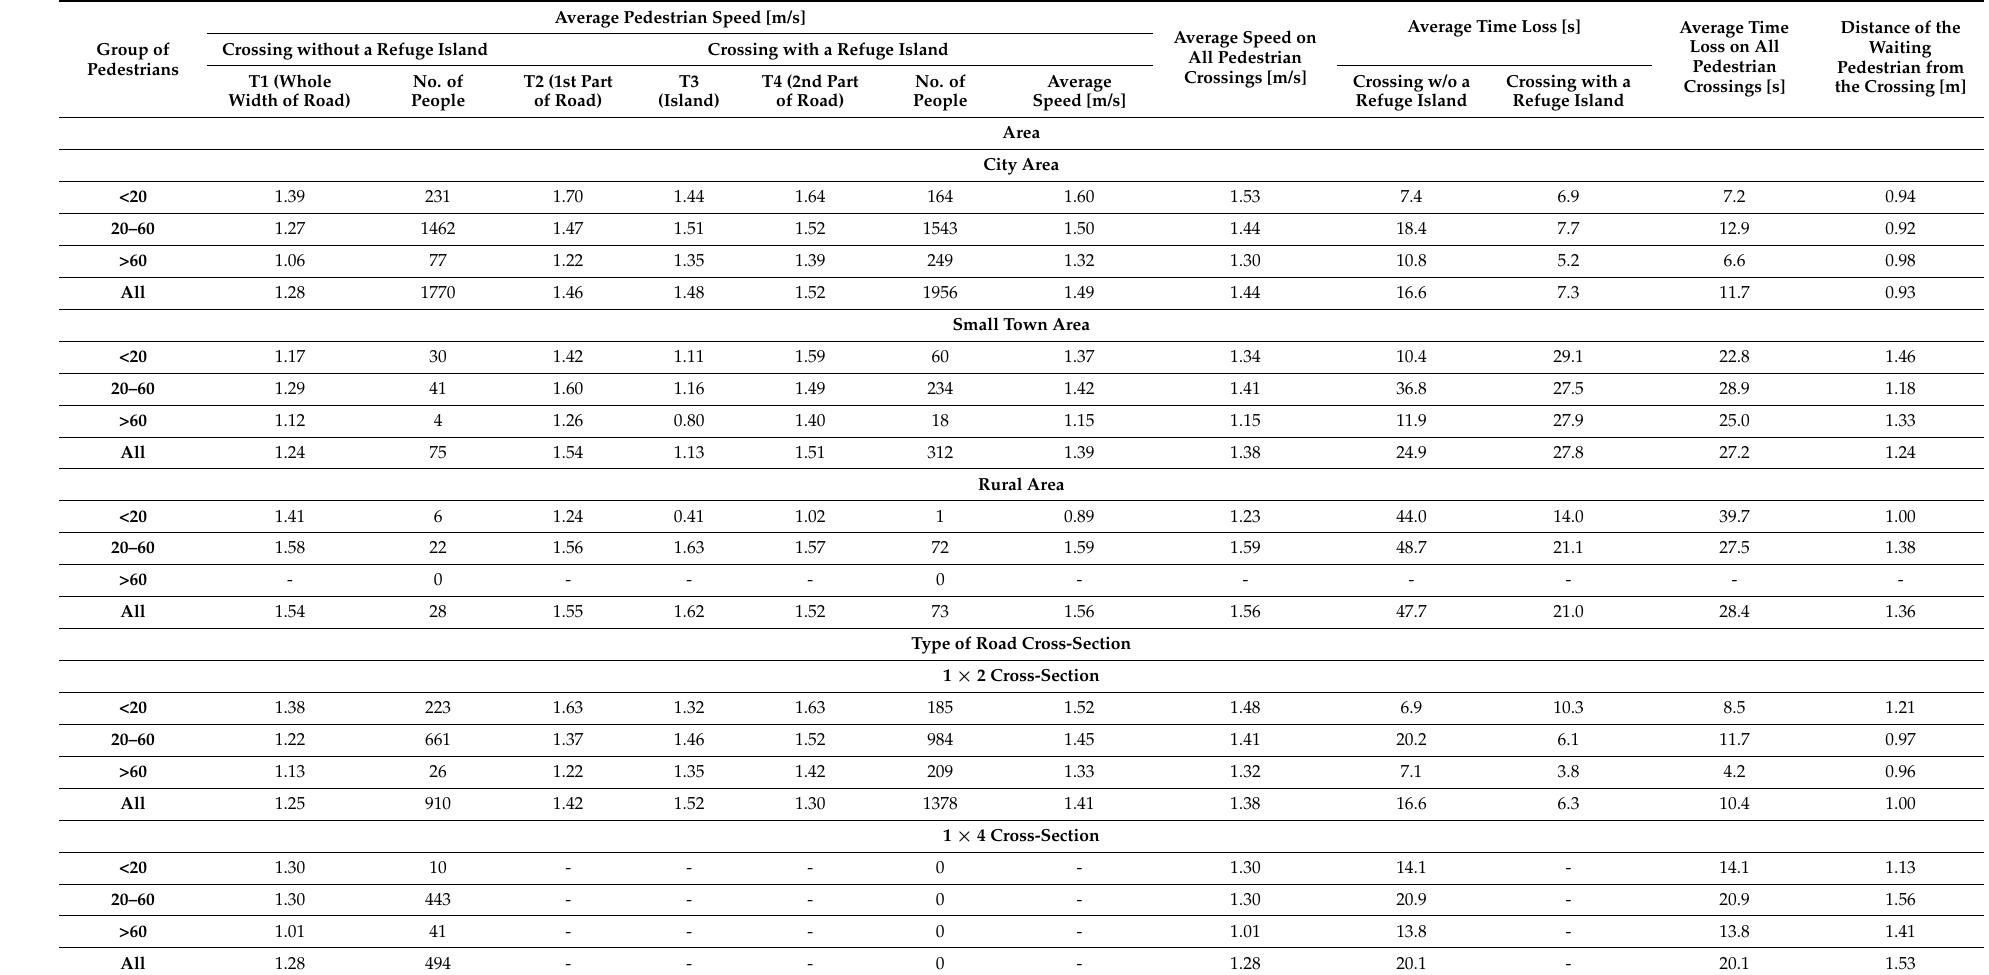
Table 1. Features of pedestrian